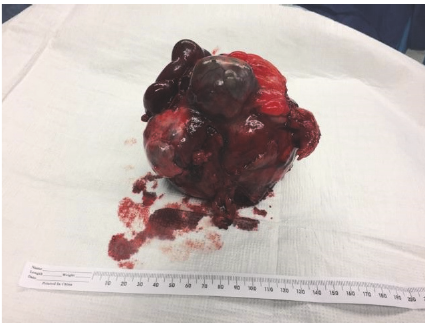
Figure 3: Postoperative photo of intact gossypiboma specimen with attached right ovary and portion of small bowel.